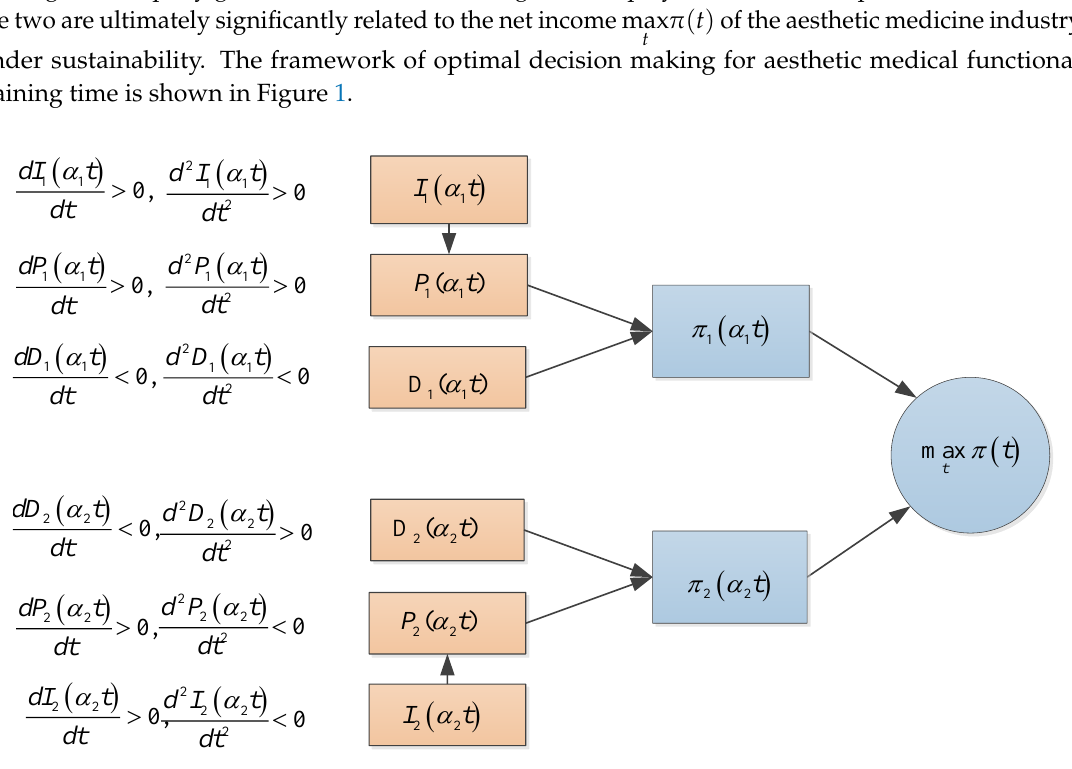
Figure 1. Optimal decision-making evaluation framework for aesthetic medical functional training investment of time.